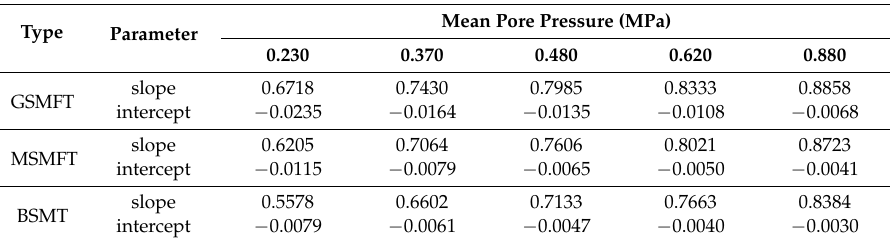
Table 3. Estimated slopes and intercepts for three pore-throat structure types at different mean pore pressures.